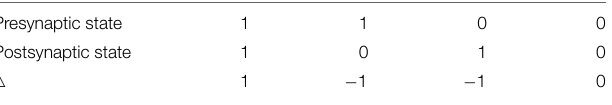
TABLE 2 | Hebbian learning rule used in the model. Presynaptic state 1 1